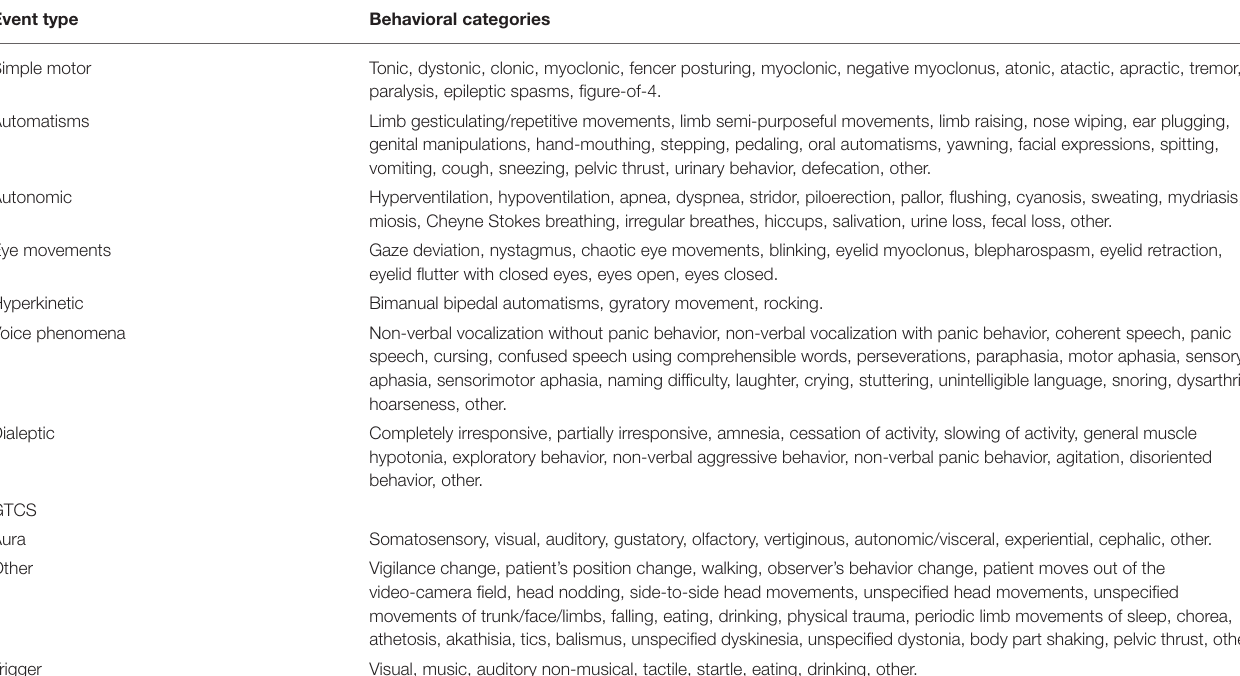
TABLE 1 | Event types in DS, and the behavioral categories appearing next in the DS hierarchy. Event type